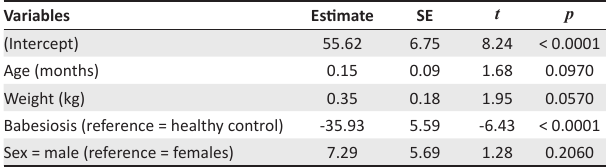
TABLE 1: Estimates from linear models of 25-hydroxyvitamin D concentrations exploring the relationship between vitamin D status and the presence of babesiosis, adjusting for other co-variables.